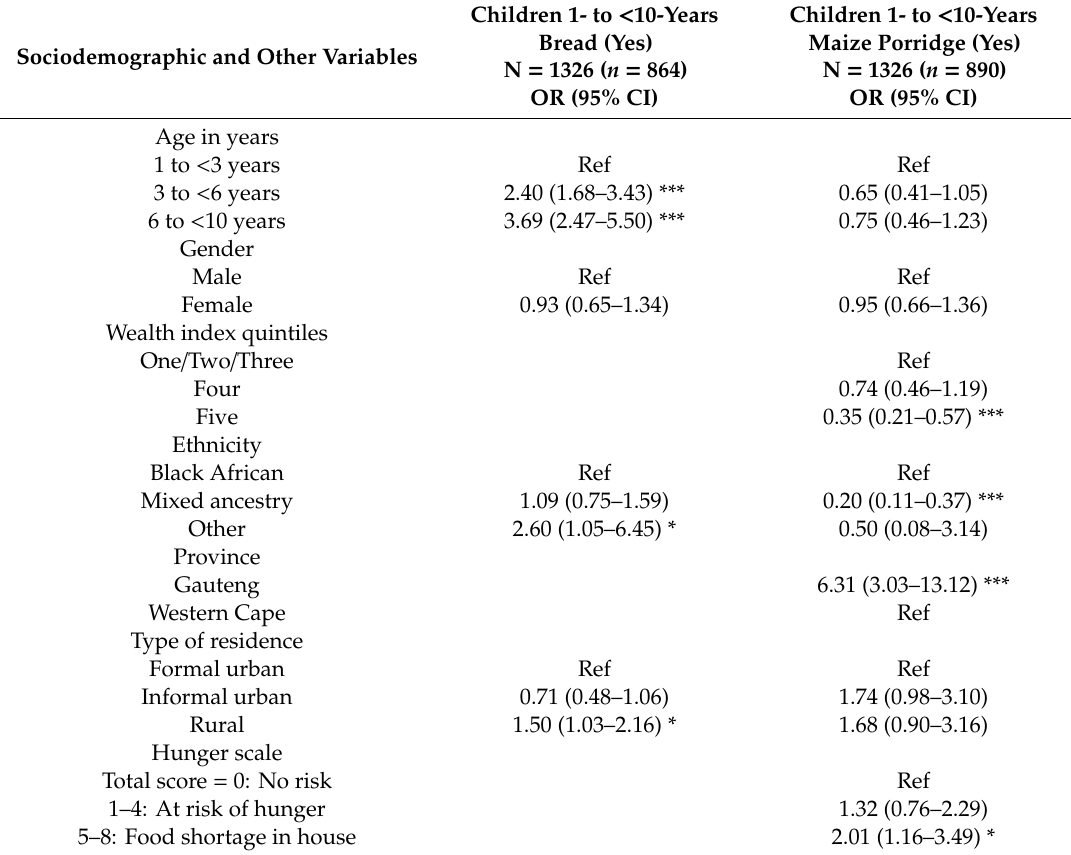
Table 8. Multivariate logistic regression analyses for identification of socio-demographic predictors of bread and maize porridge intake of children 1- to < 10-years-old during the single 24-h recall period available for the total sample (adjusted for